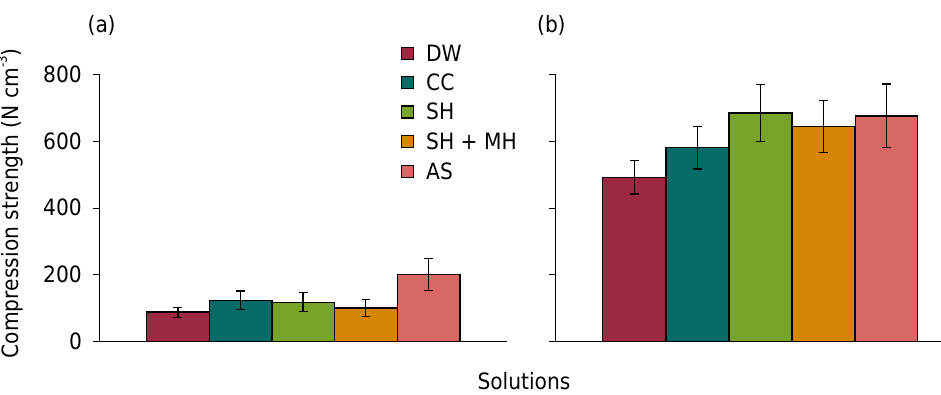
Figure 4. Mean value and standard error of the mean compressive strength of plinthite (a) and petroplinthite (b) with a 95 % confidence interval (p<0.05). DW: distilled water; CC: calcium